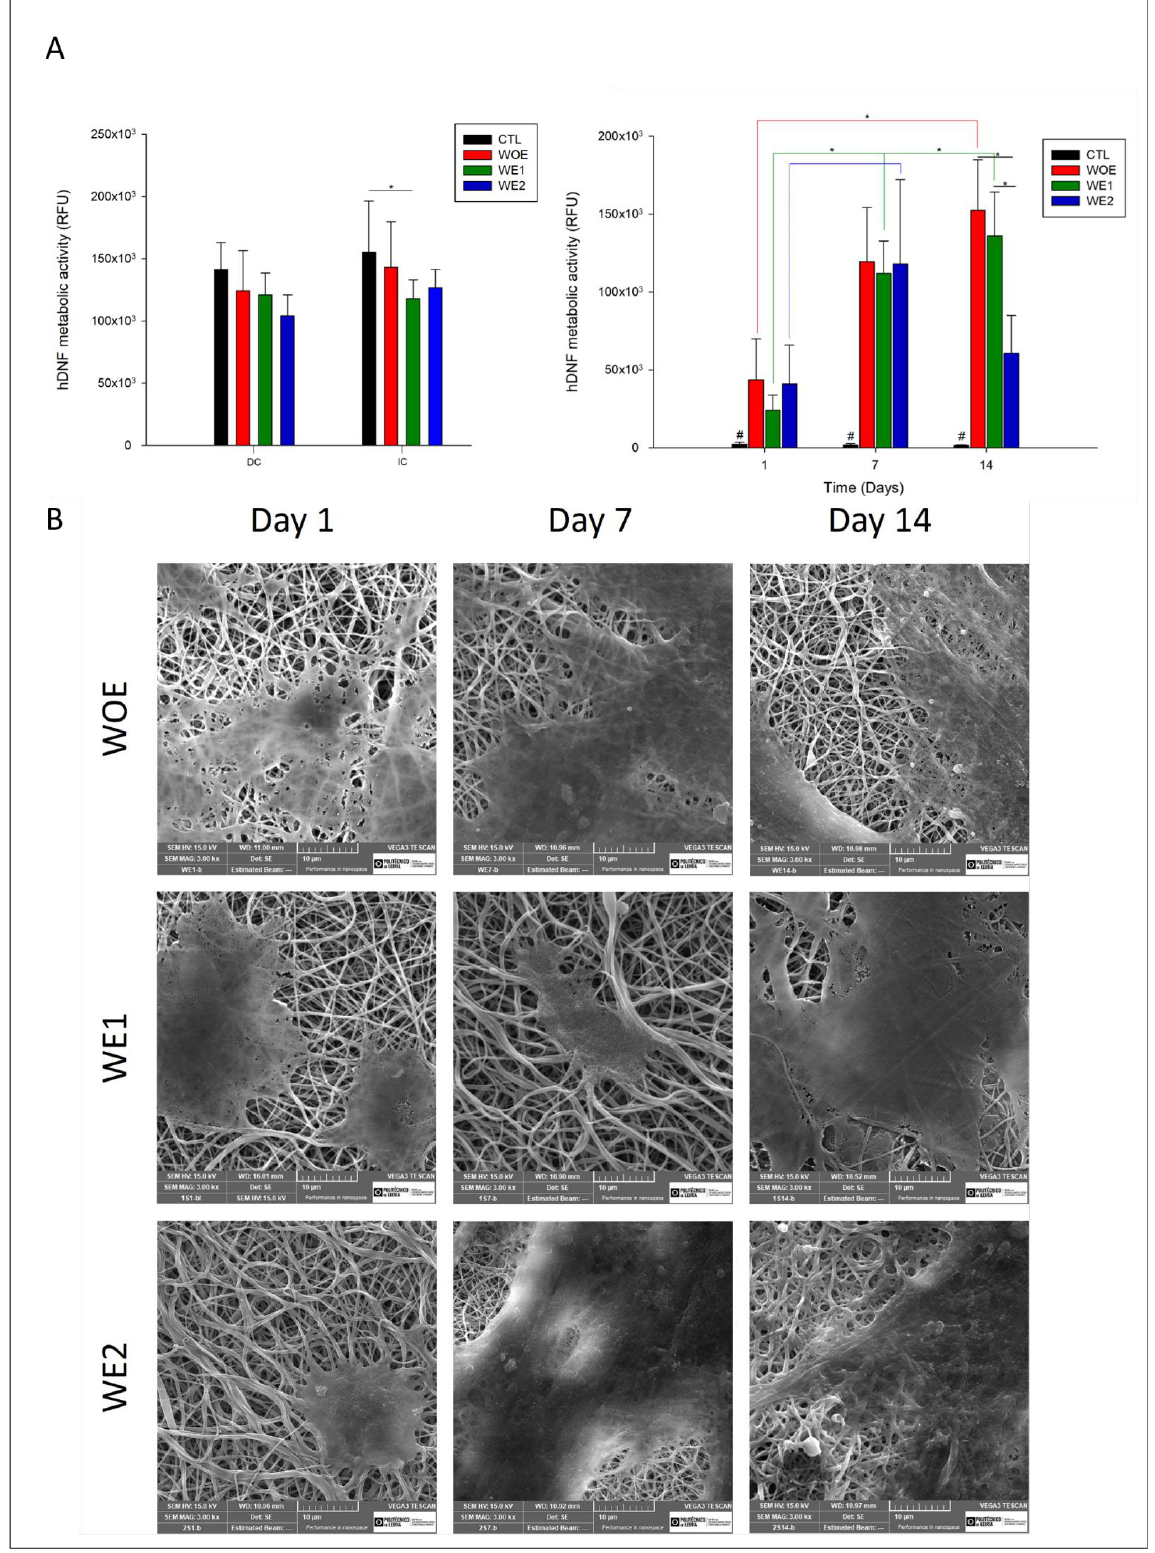
Figure 5. ( A ) On left: Cytotoxicity of electrospun meshes containing phlorotannins-enriched extract (WE1-green